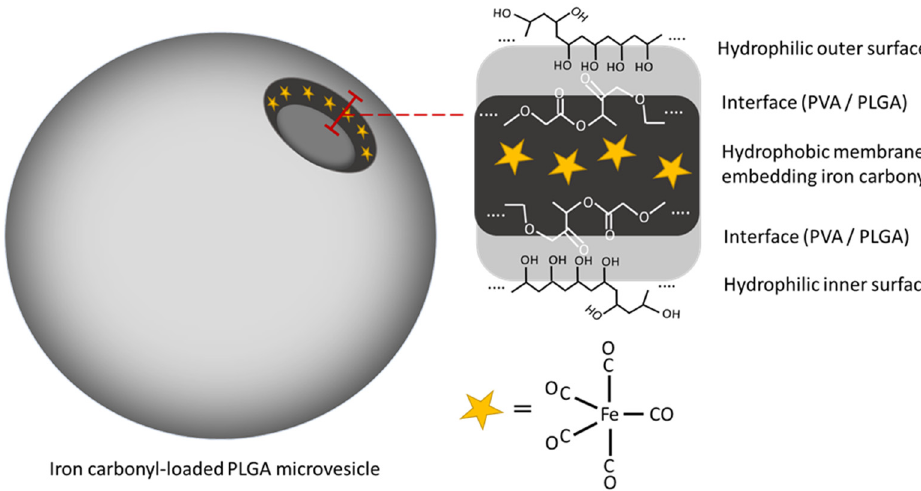
Figure 1. The vesicular structure and membrane-mimicking feature of iron carbonyl (IC)-loaded PLGA MVs. Water-insoluble IC could be embedded in the hydrophobic interior of the shell.